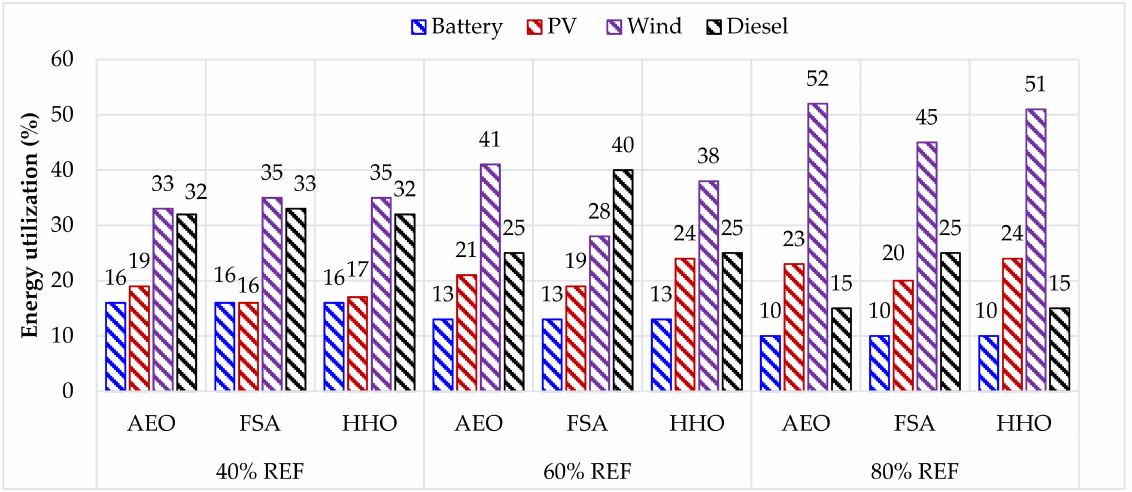
Figure 10. Energy utilization percent for AEO, FSA, and HHO without DSM and at 0%